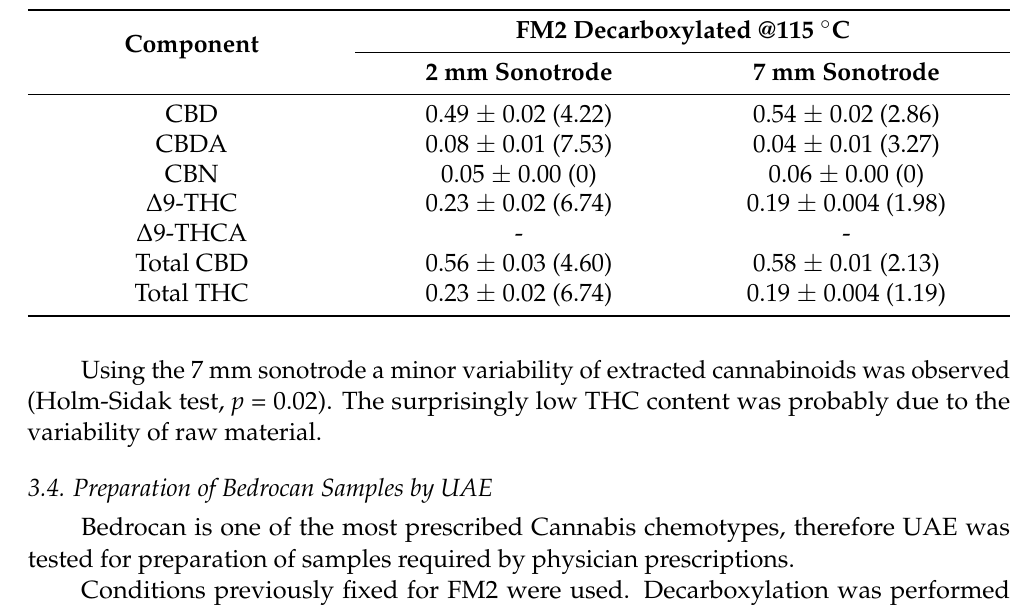
Table 5. Cannabinoids content expressed as % w/w (CV%) in samples prepared with decarboxylated FM2 by ultrasonic extraction for 10 min, using 2 mm (amplitude 60%) or 7 mm (amplitude 30%) sonotrode (50 mL sample; n =